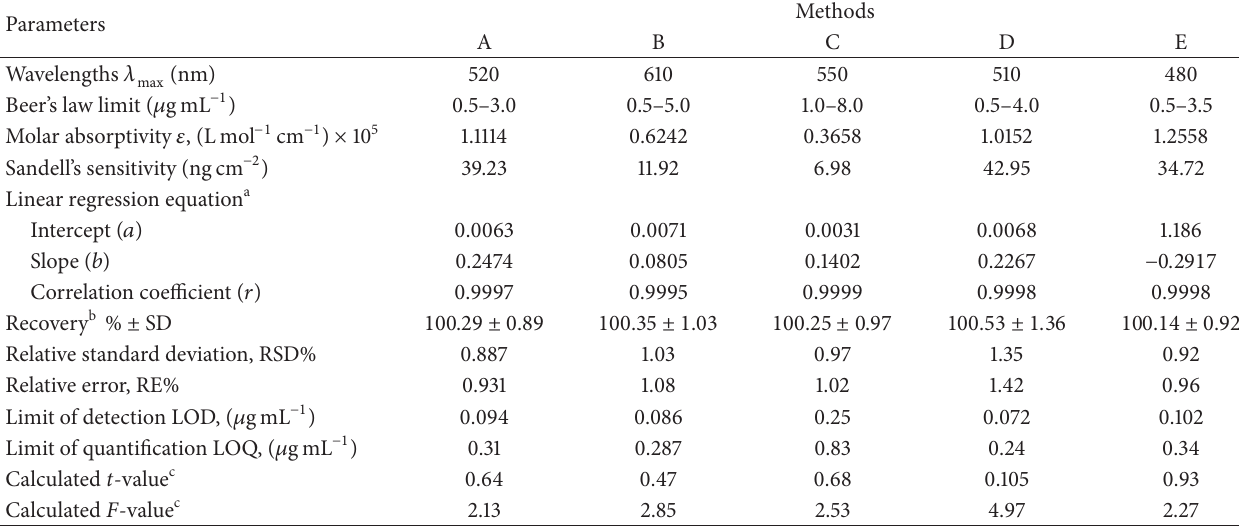
Table 2: Optical characteristics and statistical data for the regression equation of the proposed